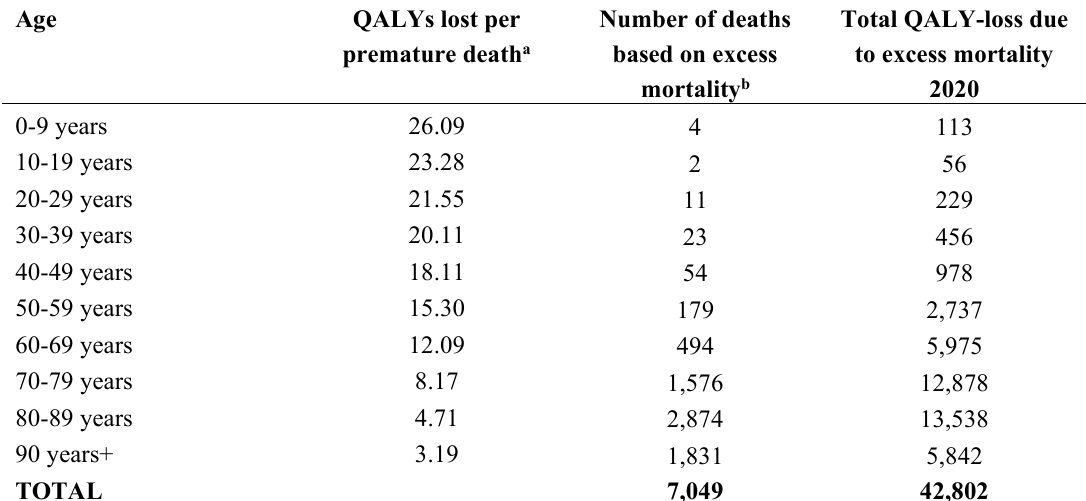
Table A3: QALY loss due to excess mortality 2020 Age QALYs lost per